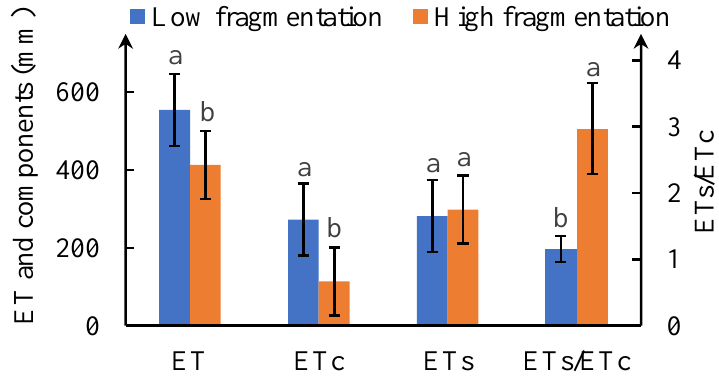
Figure 7. Significance test of evapotranspiration and components of different fragmentation plots. Different lower-case letters at ET, ETs, ETc, and ETs/ETc indicate significant differences ( p < 0.05) between the low- and the high-fragmentation plots.